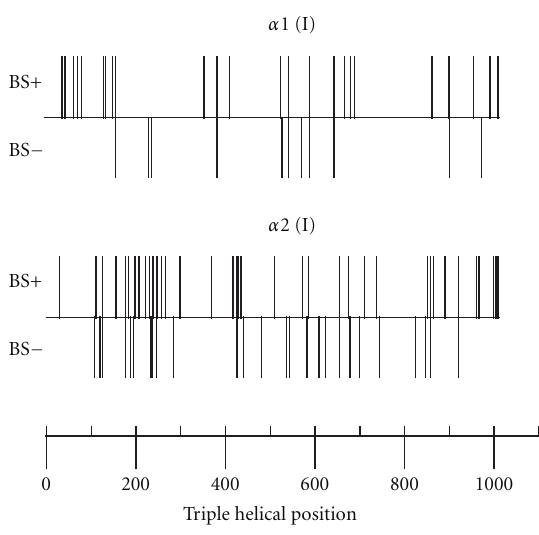
Figure 2: Relationship between the triple helical position of glycine mutations in collagen type I α chains and the presence (+) or absence ( − ) of dentinogenesis imperfecta (DI), adapted from [9].